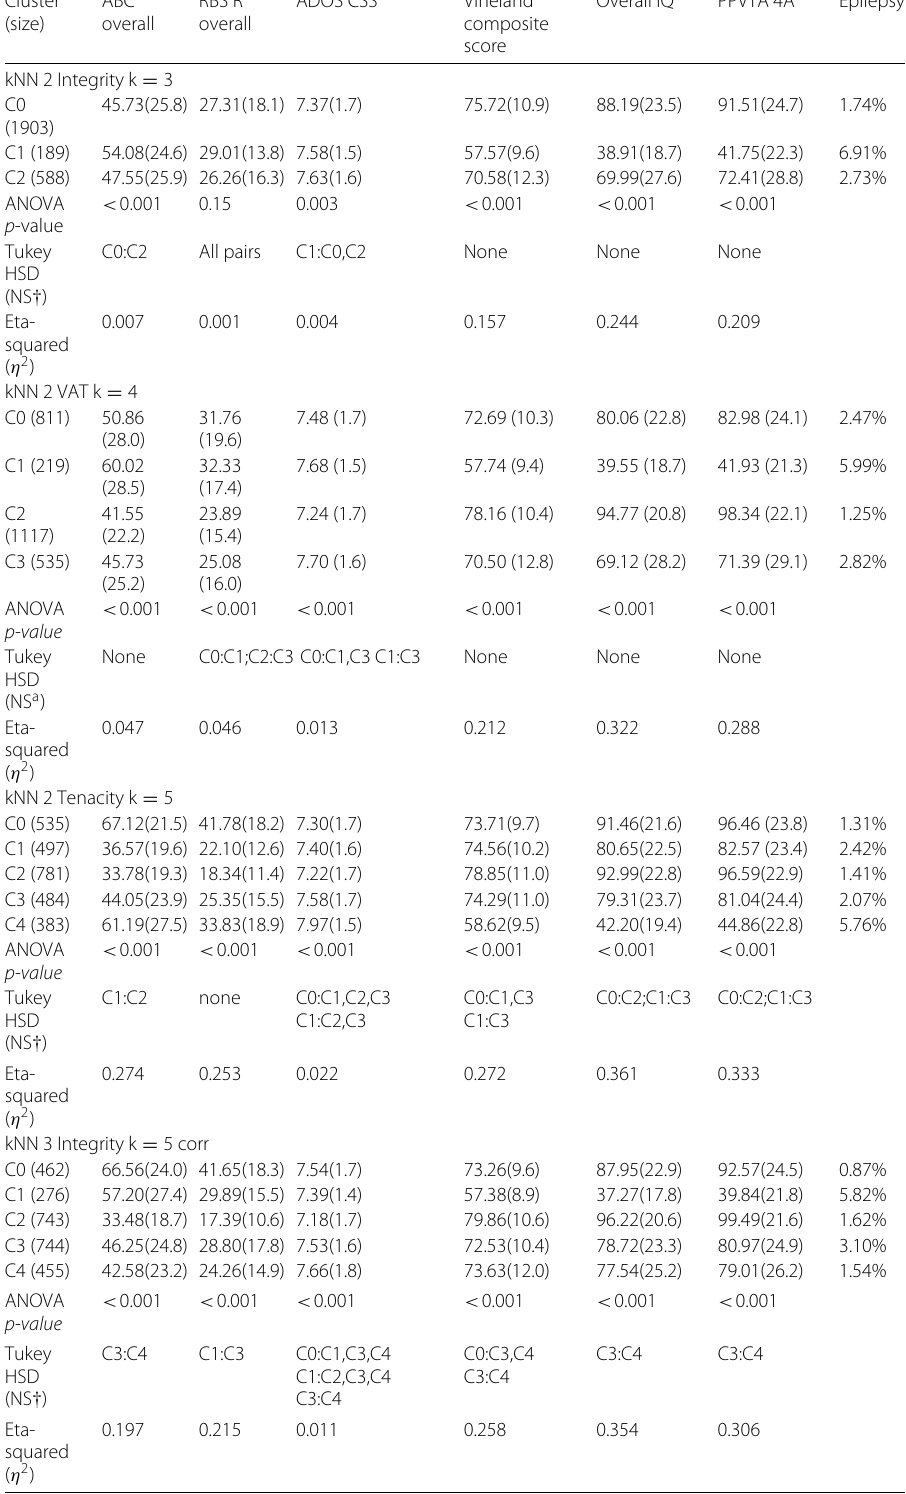
Table 6 Statistical analysis of optimal clustering configurations (complete clustering) by graph type and node resilience measure using selected ASD outcome